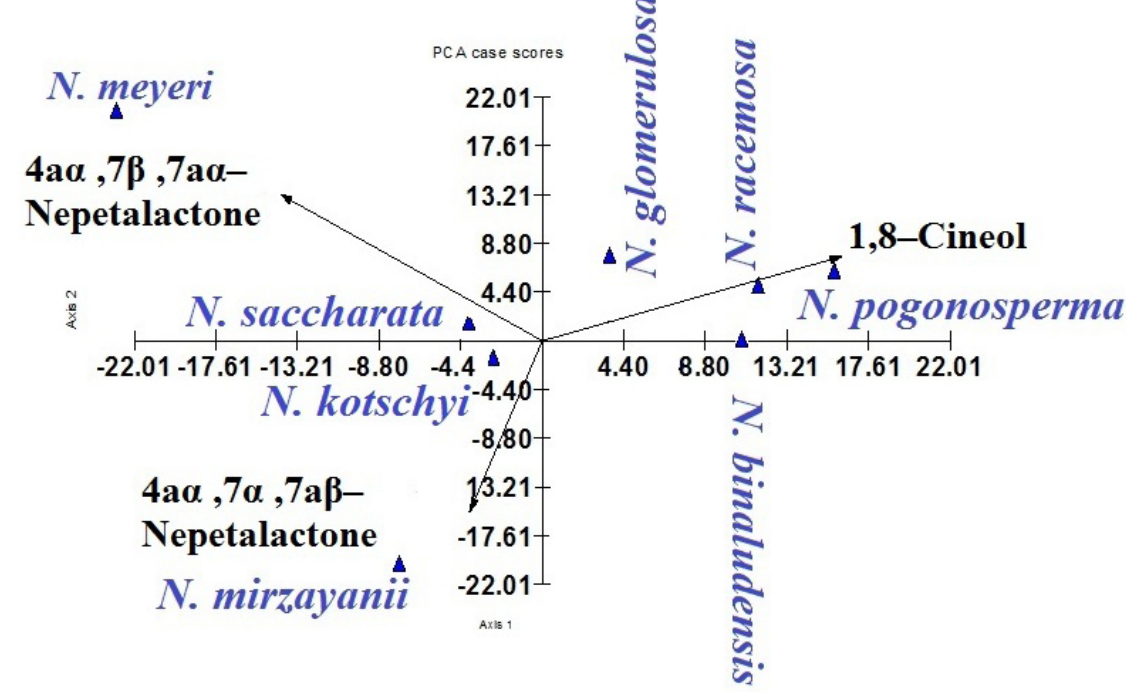
Figure 3. PCA bi-plot of the studied taxa and essential oil